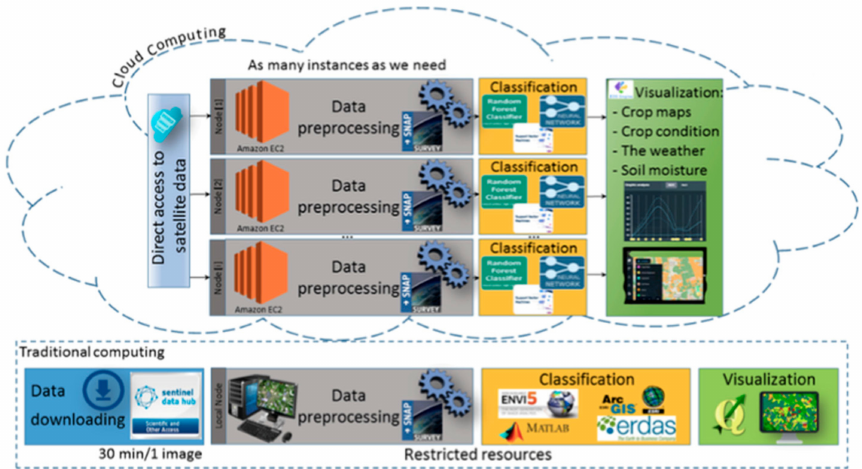
Figure 10. Workflow of satellite data processing four-level architecture for classification task [59].